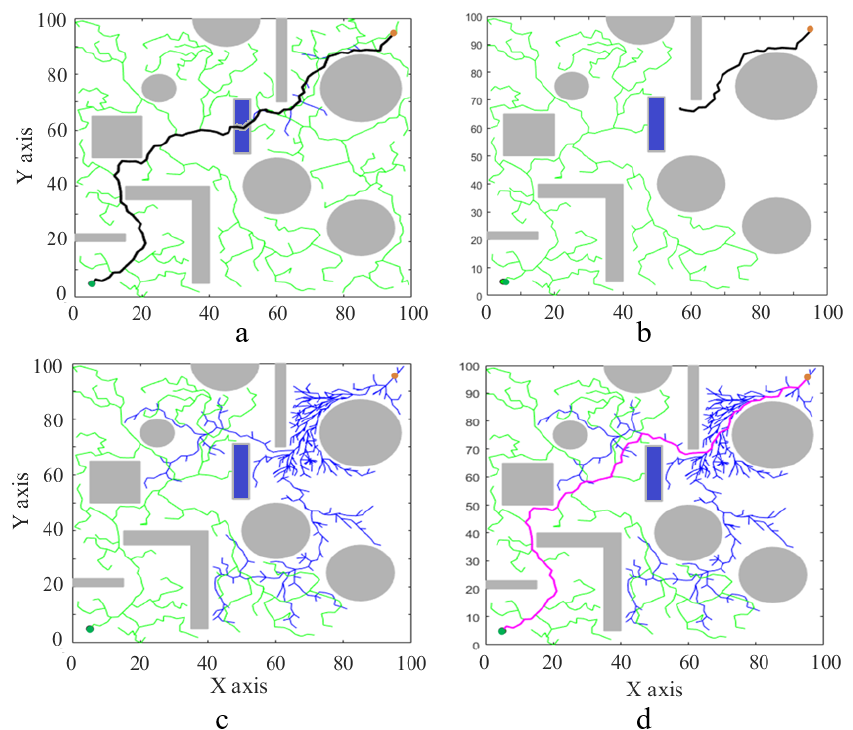
Figure 17. The newly installed drainage wire affects robot movement.